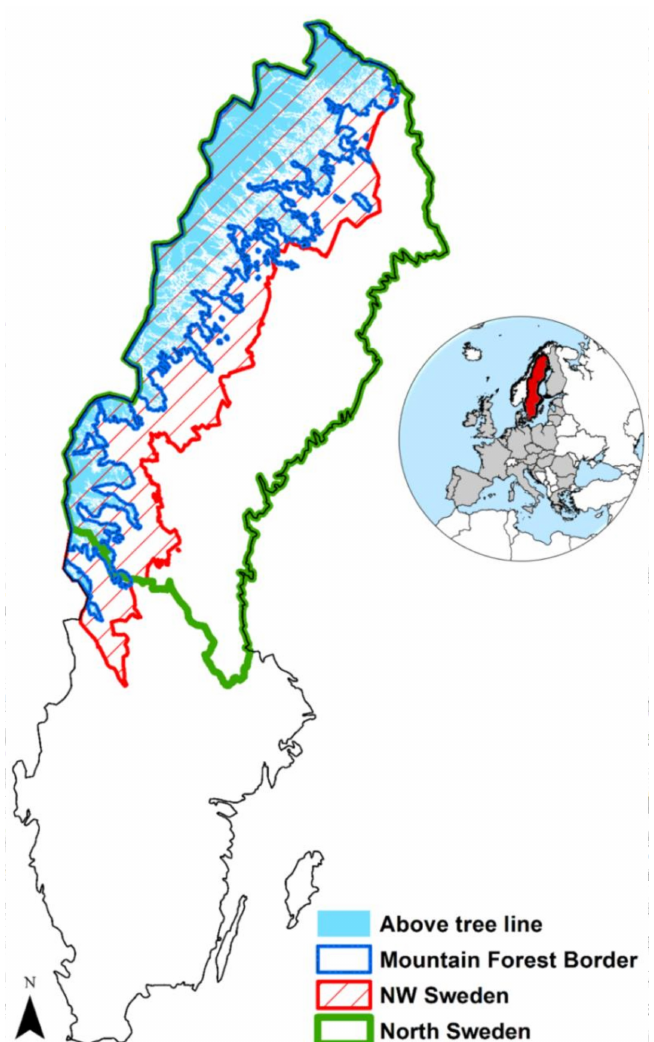
Figure 1. Our study covers four spatial extents: (1) forests below the tree line west of the mountain forest border, (2) NW Sweden defined as the 15 municipalities hosting mountain forest (hatched), (3) the five counties in north Sweden forming the informal region north Sweden (“Norrland”), and (4) entire Sweden with its policies. The inset map shows the location of Sweden in the European